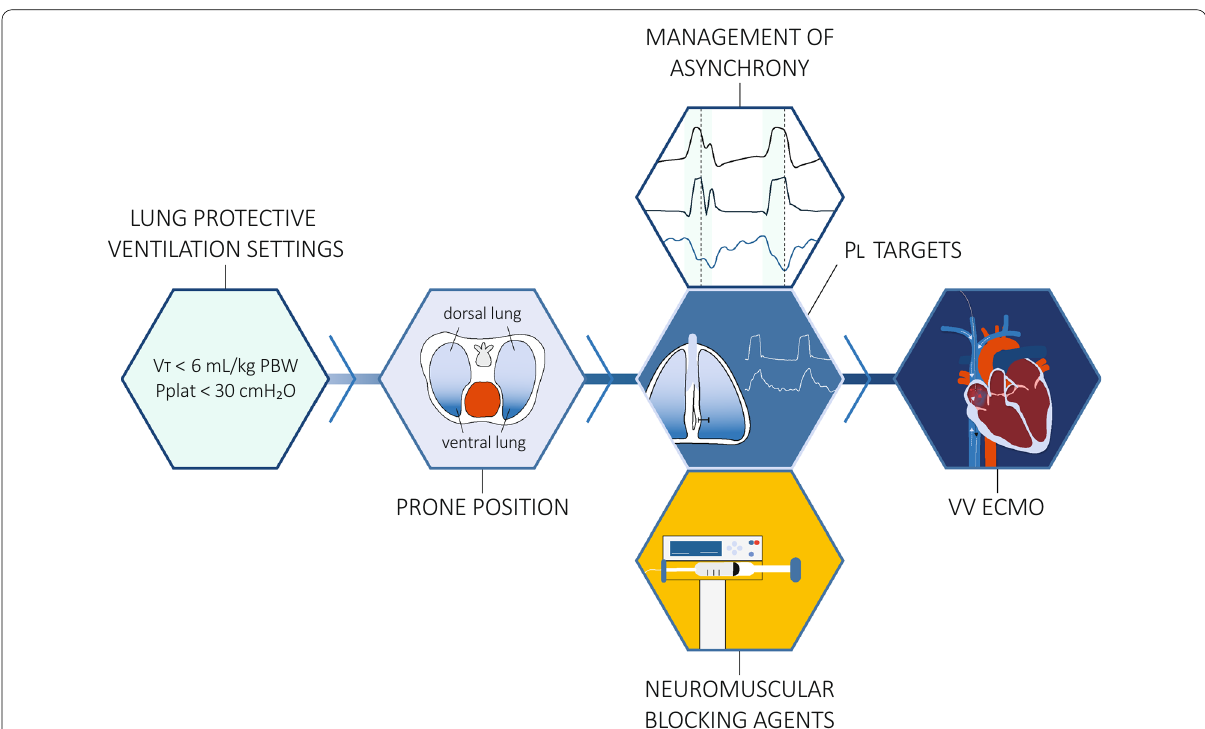
Fig. 2 Illustration of therapeutic options in ARDS patients that should be considered prior to employing ECMO treatment. Equal weight is given to the management of asynchrony, transpulmonary pressure (PL) targets, and administration of neuromuscular blocking agents, in order to illustrate that specific patients may benefit from specific strategies (e.g. PL measurements in obese patients, and paralysis in patients with high respiratory drive or reverse triggering (entrainment) despite sedation). VT, tidal volume; Pplat, plateau pressure; VV ECMO, veno-venous extracorporeal membrane